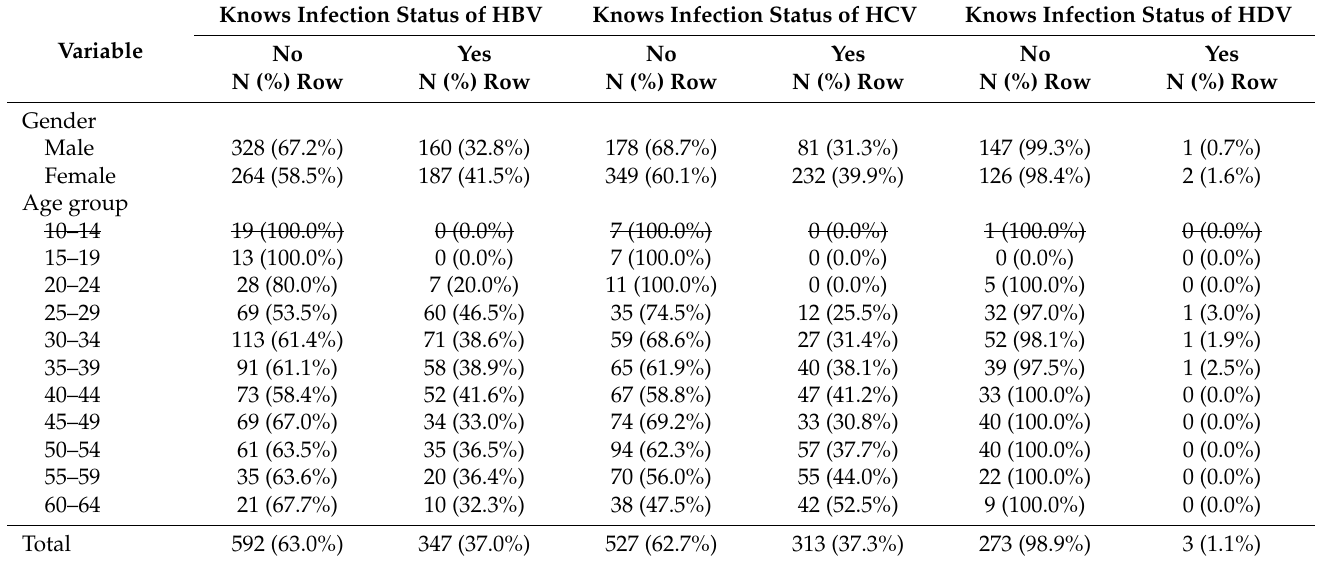
Table 4. Awareness of HBV, HCV, and HDV infection